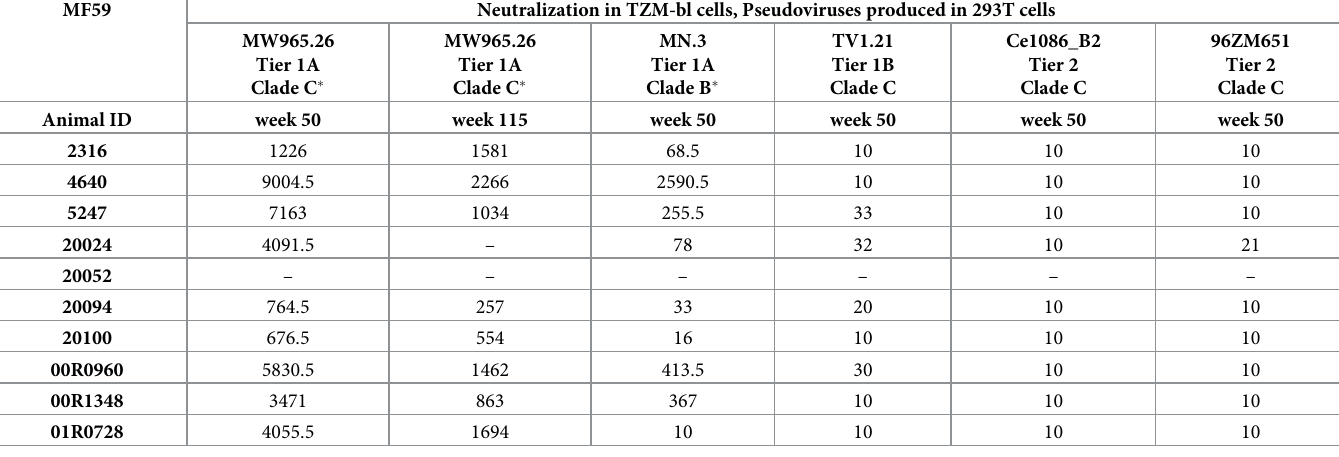
Table 5. Serum neutralizing activity against HIV strains in animals immunized in the MF59 study. MF59 Neutralization in TZM-bl cells, Pseudoviruses produced in 293T